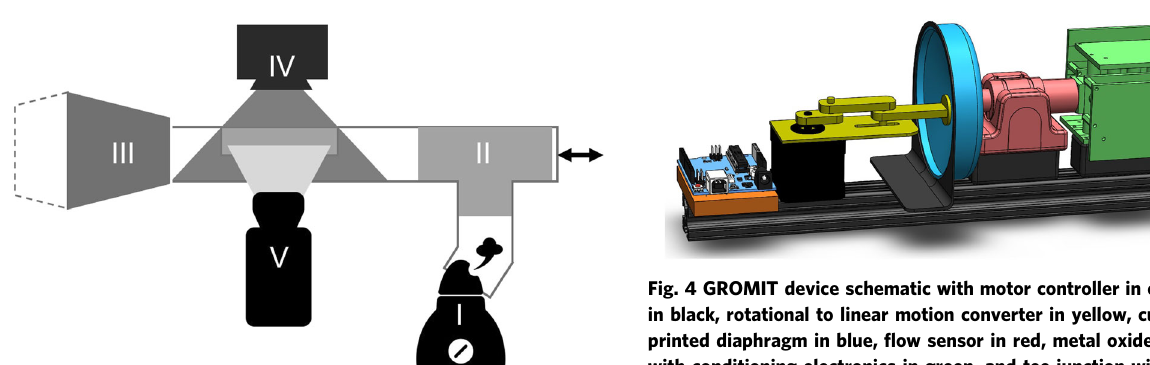
line indicates that snif fi ng occurs 10 times faster than breathing.